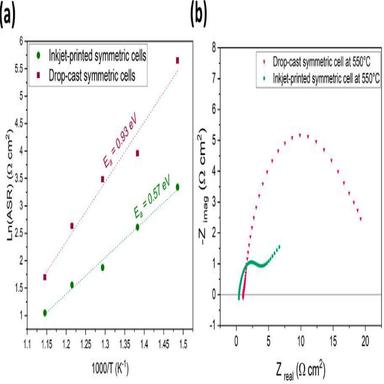
Comparing the electrochemical performance of inkjet-printed and drop-cast symmetric cells by (a) Arrhenius plot and (b) Impedance spectra at 550 ◦C.